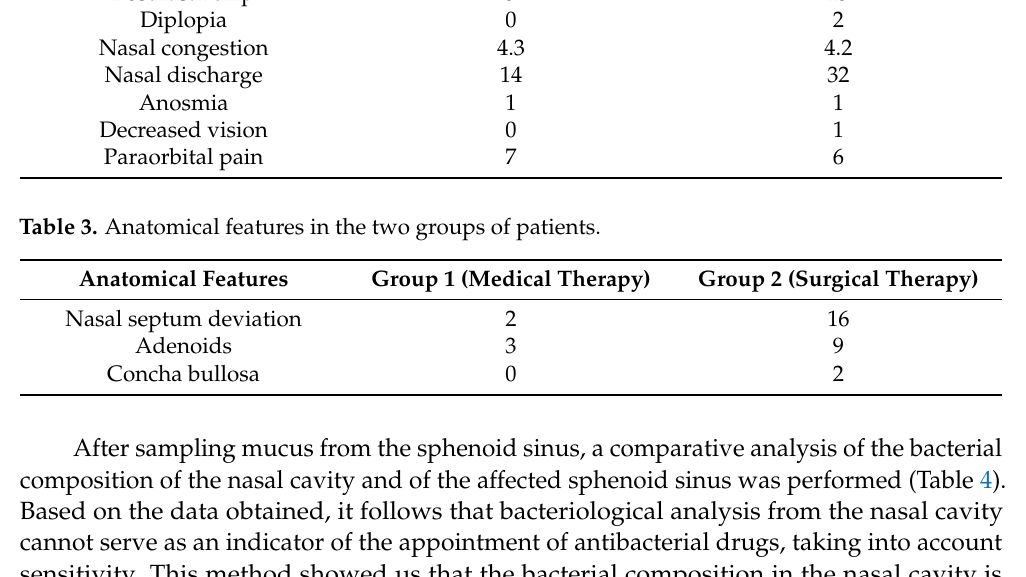
Table 3. Anatomical features in the two groups of patients.